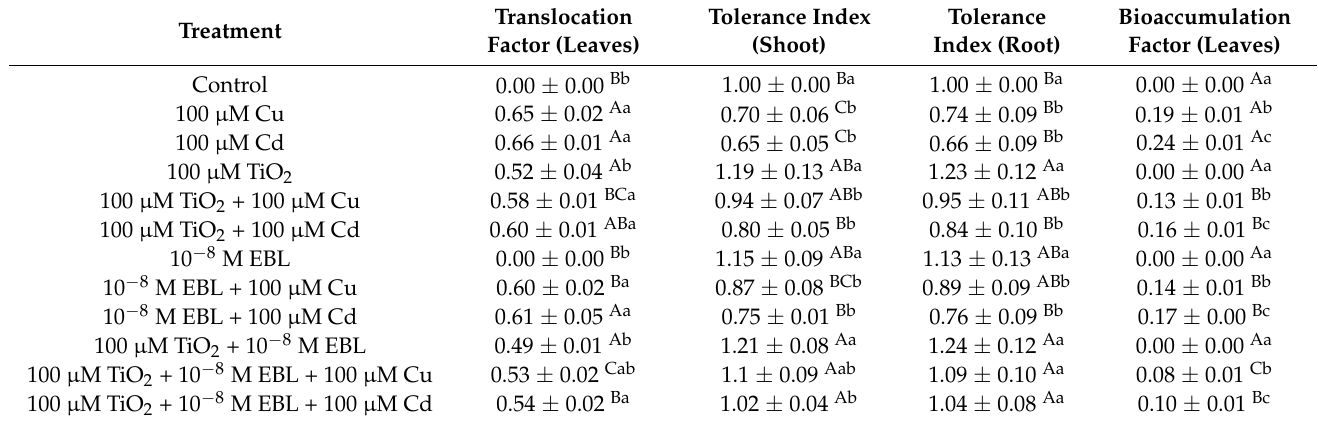
Table 5. Changes in the translocation factor and tolerance index of shoots and roots in response to 24-epibrassinolide and titanium oxide nanoparticles individually or in combination with 100 µ M Cu and 100 µ M Cd compared with the control treatment. Each data point is the mean ± SE of four replicates. The capital letters ( A–C ) indicate significant differences between treatments of control (C), titanium (Ti), 24-epibrassinolide (EBL), and 24-epibrassinolide involving individual or combined application of titanium oxide nanoparticles (EBL–TiO 2 NPs) under 100 µ M Cu and 100 µ M Cd (the bars with similar colors), while the lowercase letters ( a–c ) denote statistically significant differences at each concentration of the co-application of EBL and TiO 2 NPs individually or in combination with 100 µ M Cu and 100 µ M Cd (the bars with various colors) based on Tukey (cid:48) s test ( p <